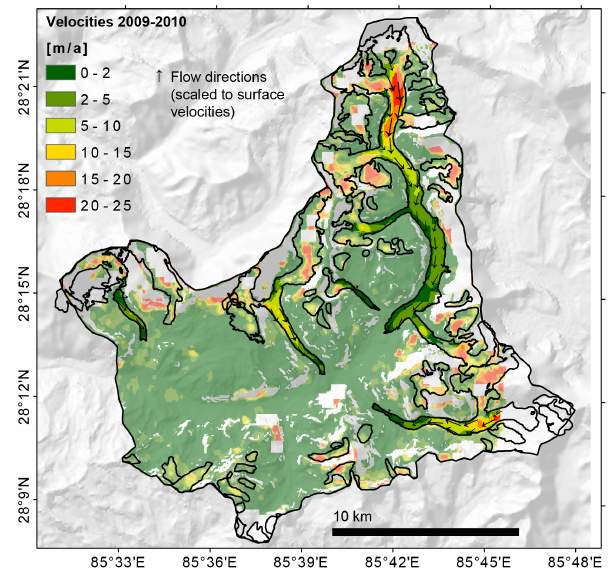
Figure 13. Surface velocities 2009–2010 cropped to catchment boundaries. Values have units of meters per year and are derived by cross-correlation feature tracking. Off-glacier velocities are shown in transparent